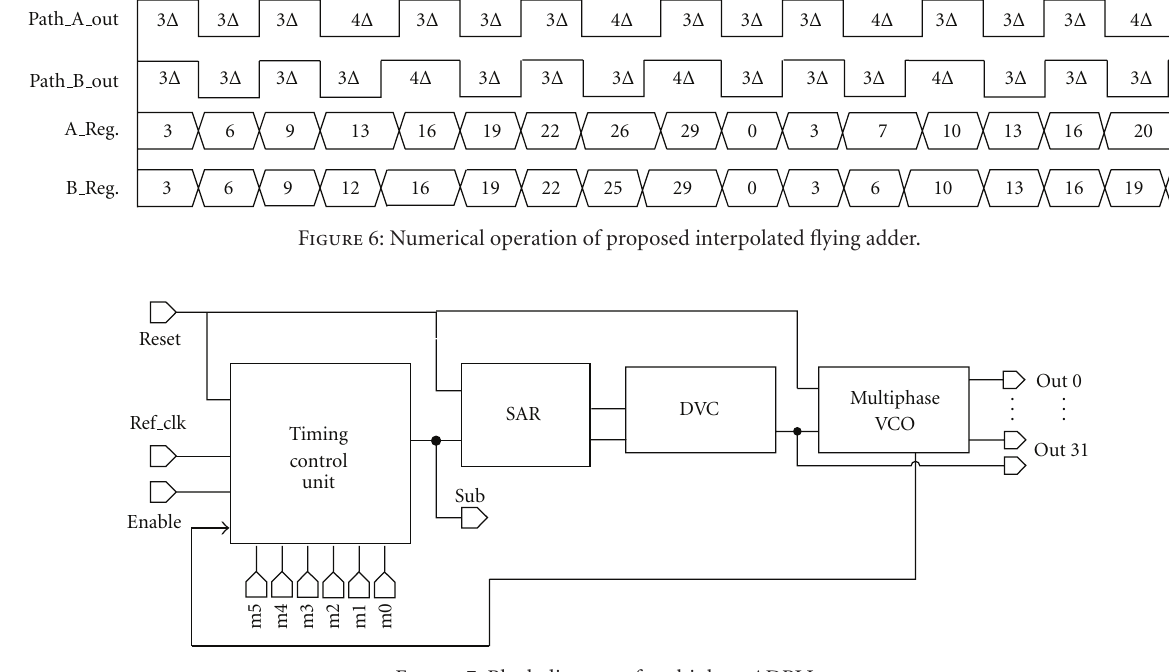
Figure 7: Block diagram of multiphase ADPLL.